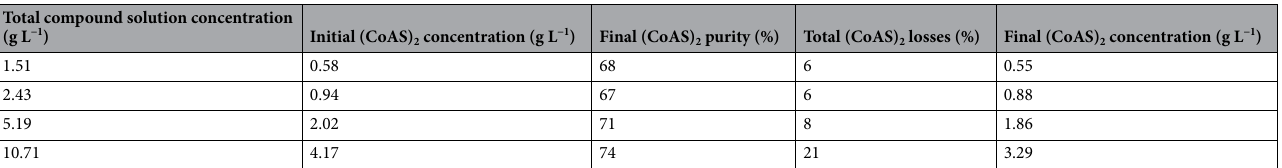
Table 2. Predicted (CoAS) 2 losses at 4 bars and diafiltration volume 3.